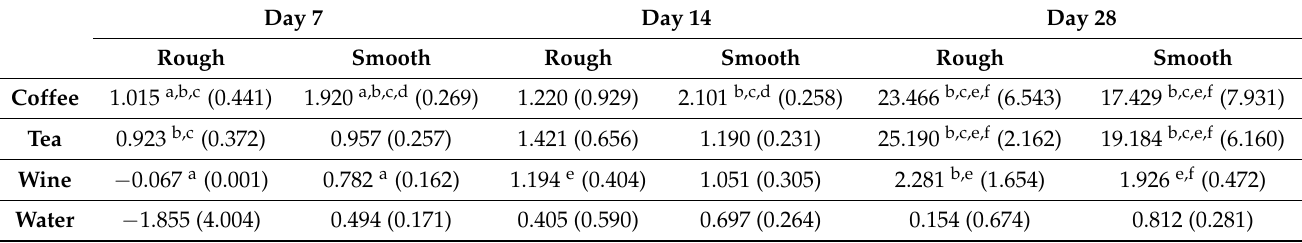
Table 3. Changes in percent light transmittance, ∆ T, for copolyester retainer specimens with dif- ferent surface textures at different times in different staining solutions (mean ∆ T value in % ± standard